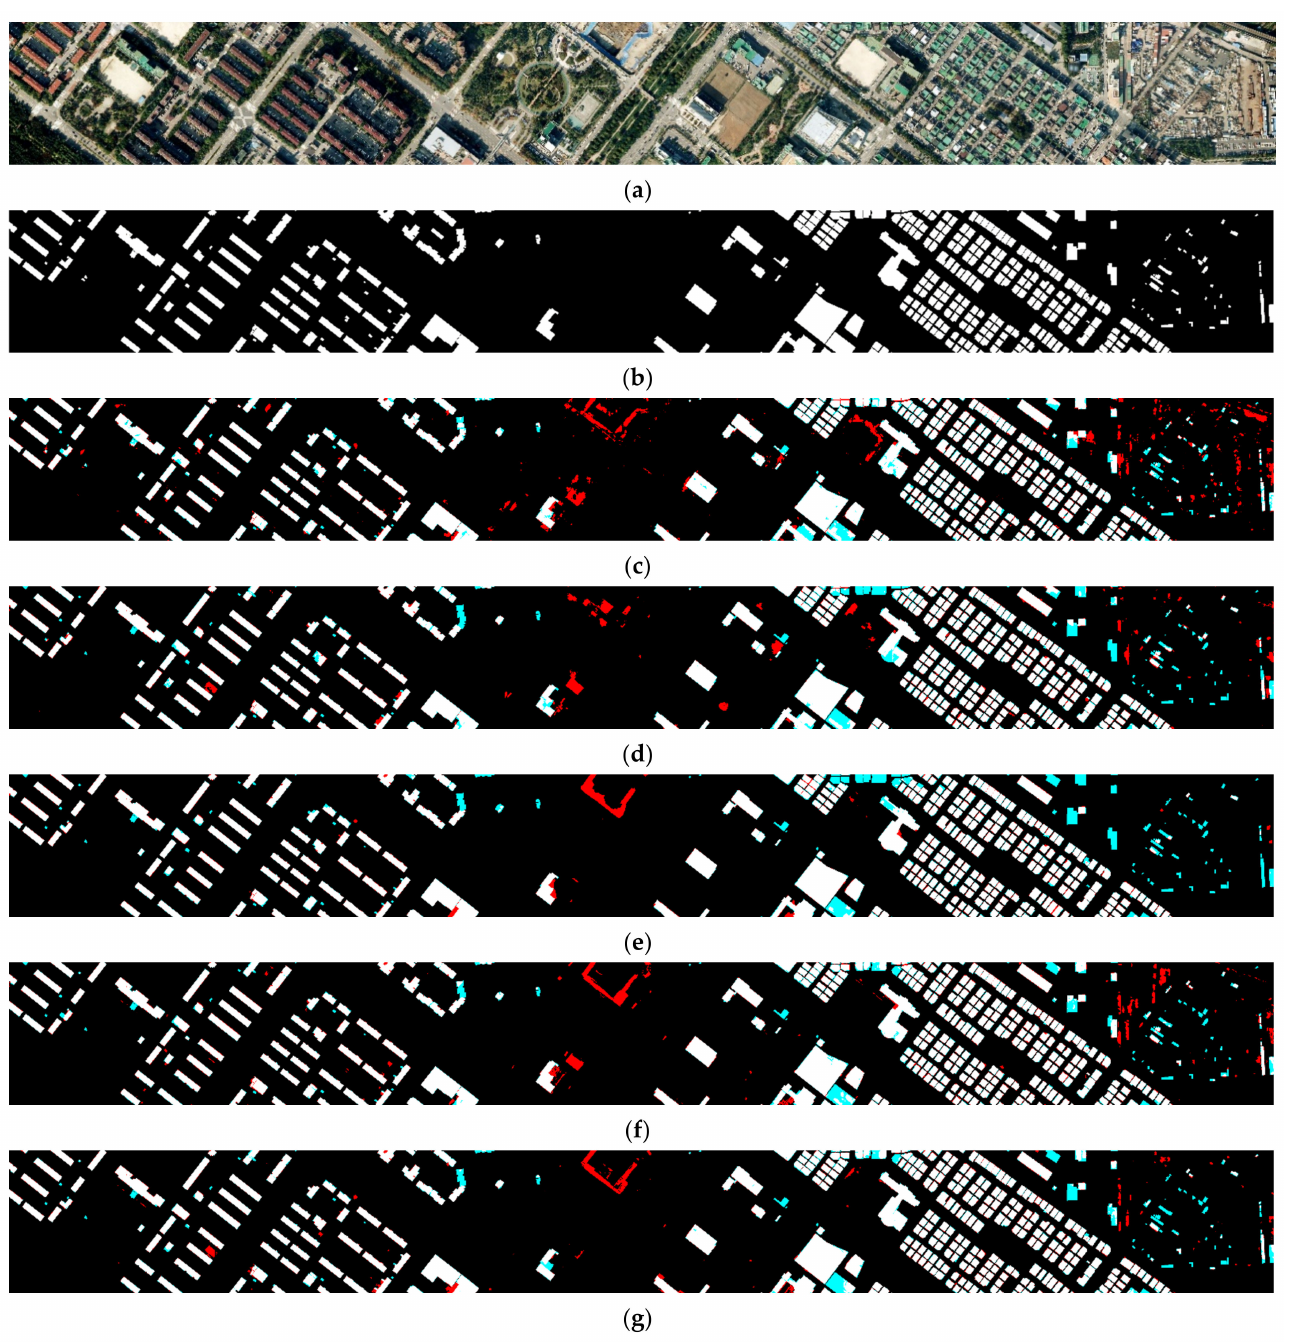
Figure 8. Building extraction results for site 1 (residential area) according to each deep learning model. The red and cyan regions indicate false positives and false negatives, respectively. ( a ) Original image. ( b ) Ground-truth labels. ( c ) Results of SegNet. ( d ) Results of U-Net. ( e ) Results of FC-DenseNet. ( f ) Results of HRNet-v2. ( g ) Results of